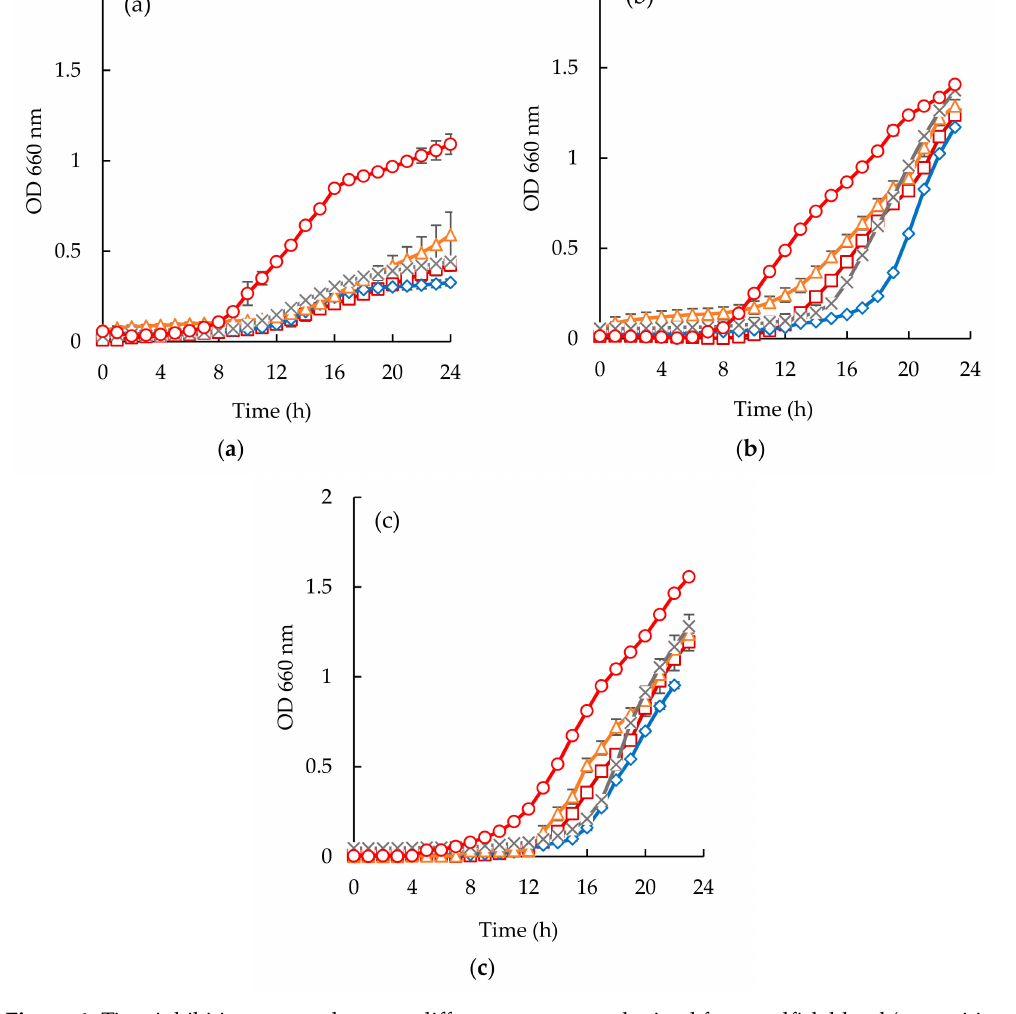
, positive (cid:35)